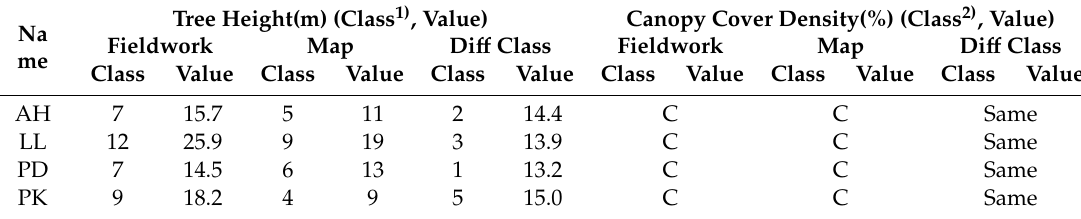
Table 10. Di ff erences between the fieldwork data and the forest type map records.